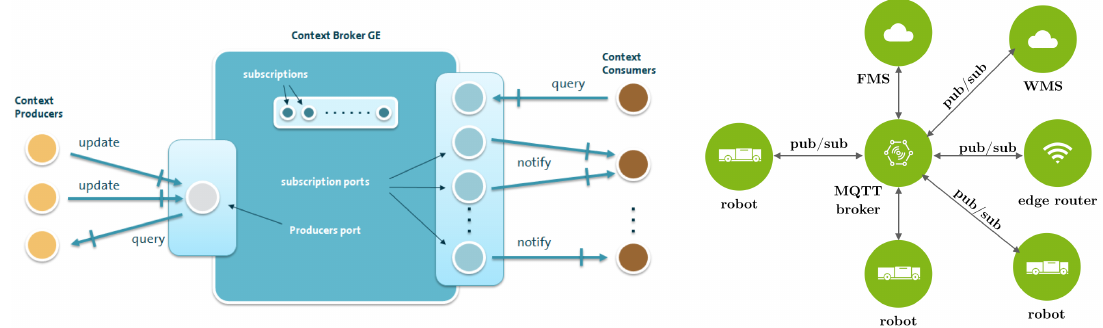
Fig. 1. Context brokers communication flow Fiware (left), 4 MQTT stack as deployed (right)